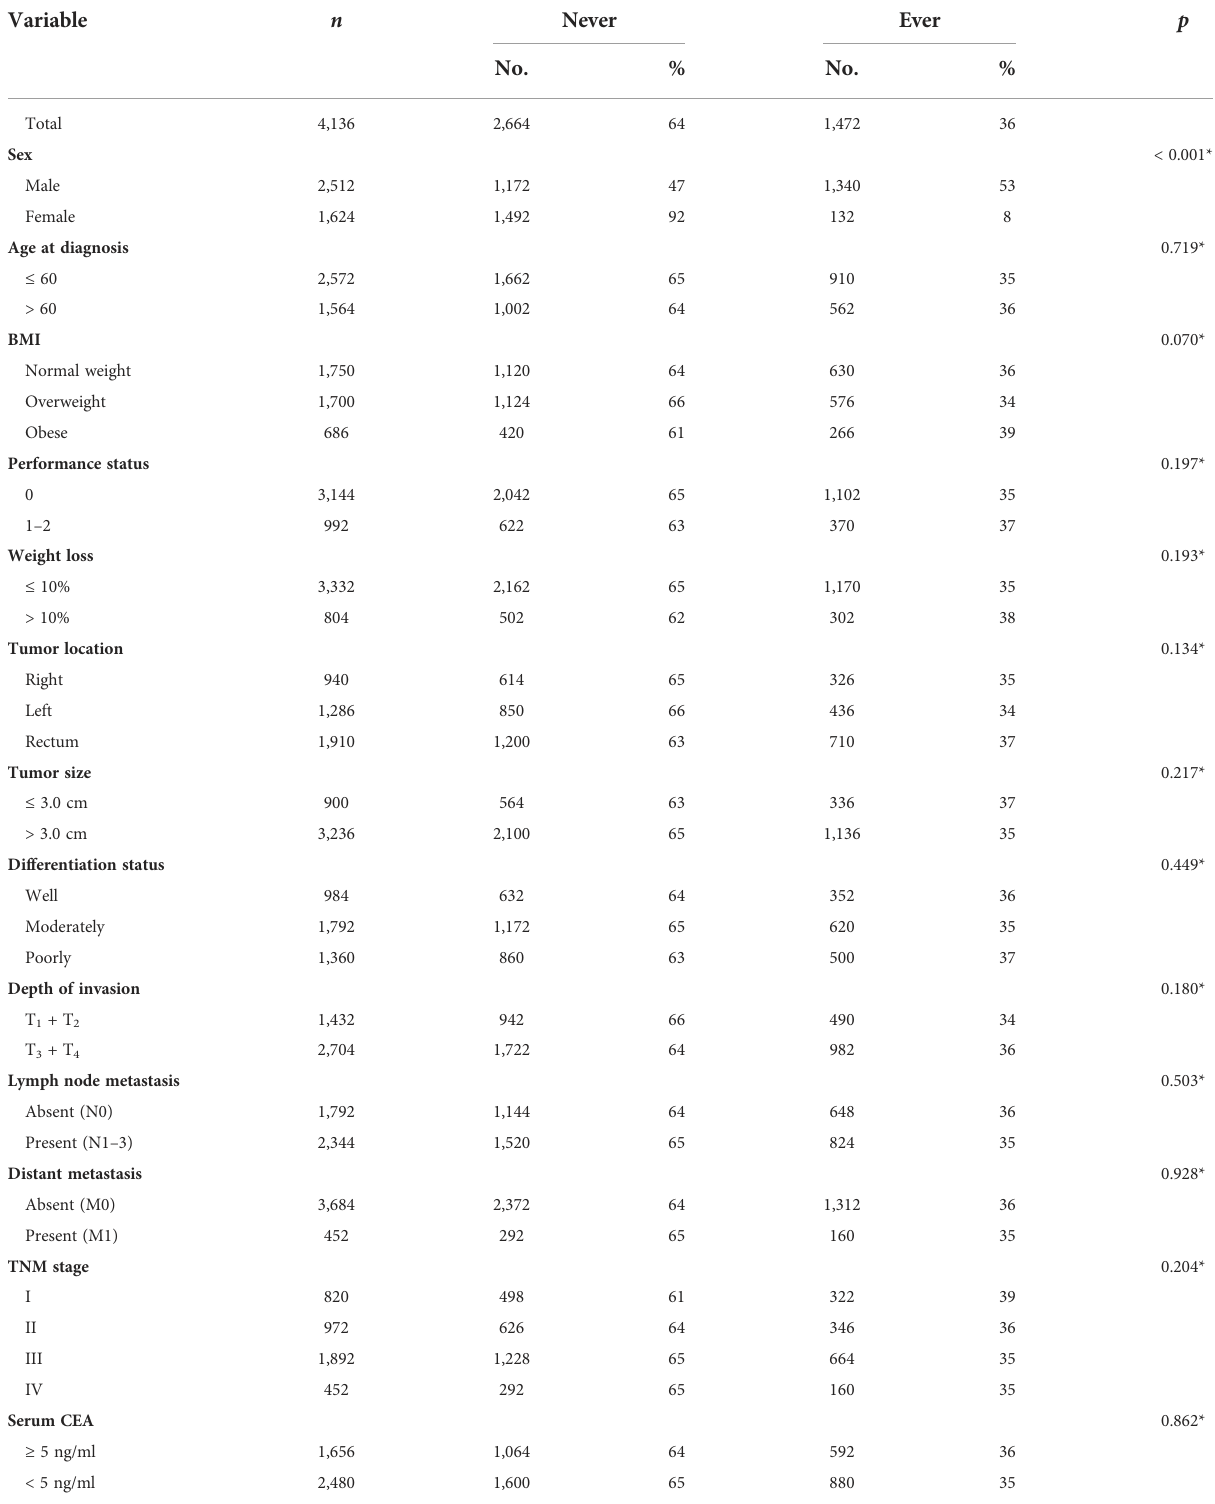
TABLE 1 Clinical characteristics of patients according to smoking